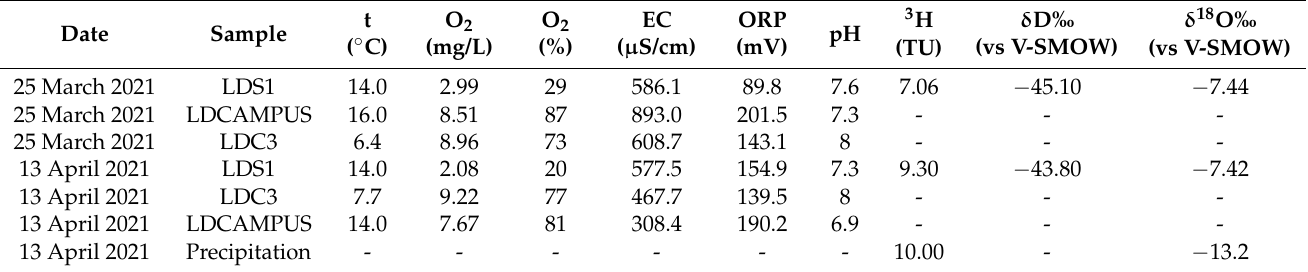
Table 1. Isotopic and field data. The dot represents not-analyzed